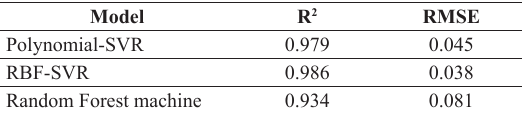
Table 3. Performance of Machine learning models.